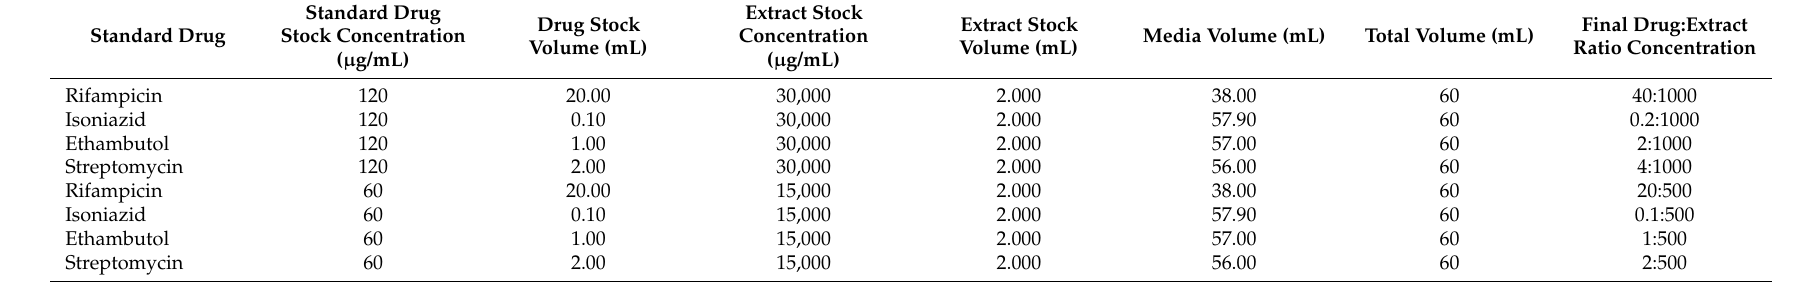
Table 1. Summary of the preparation to make the Hibiscus sabdariffa and Piper crocatum combination with standard antituberculosis drugs.